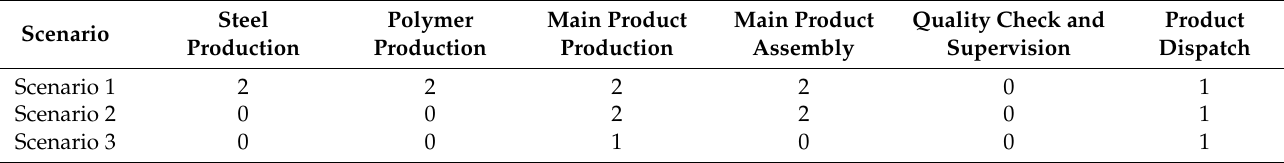
Table 24. Number of estimated/assumed robots involved in the manipulation of different